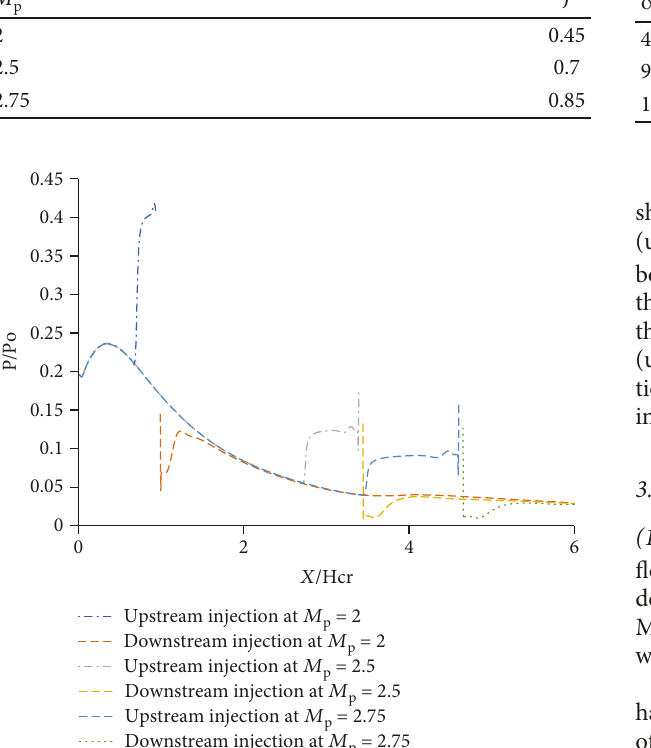
Figure 13: In fl uence of injection location on the static pressure distribution along the injector wall.